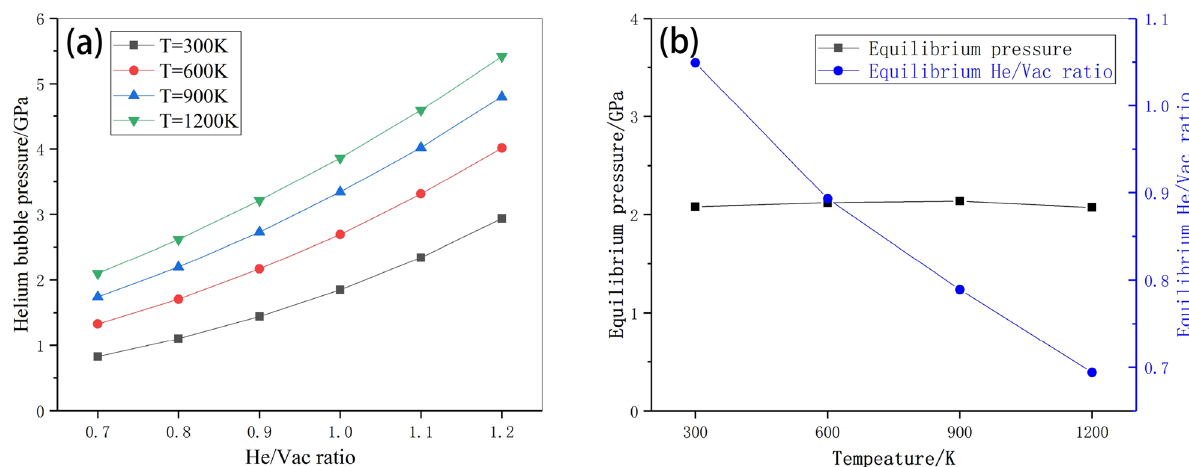
Figure 5. ( a ) Helium bubble pressure with respect to He/Vac ratio regarding four different temperatures. ( b ) Equilibrium pressure and equilibrium He/Vac ratio with respect to